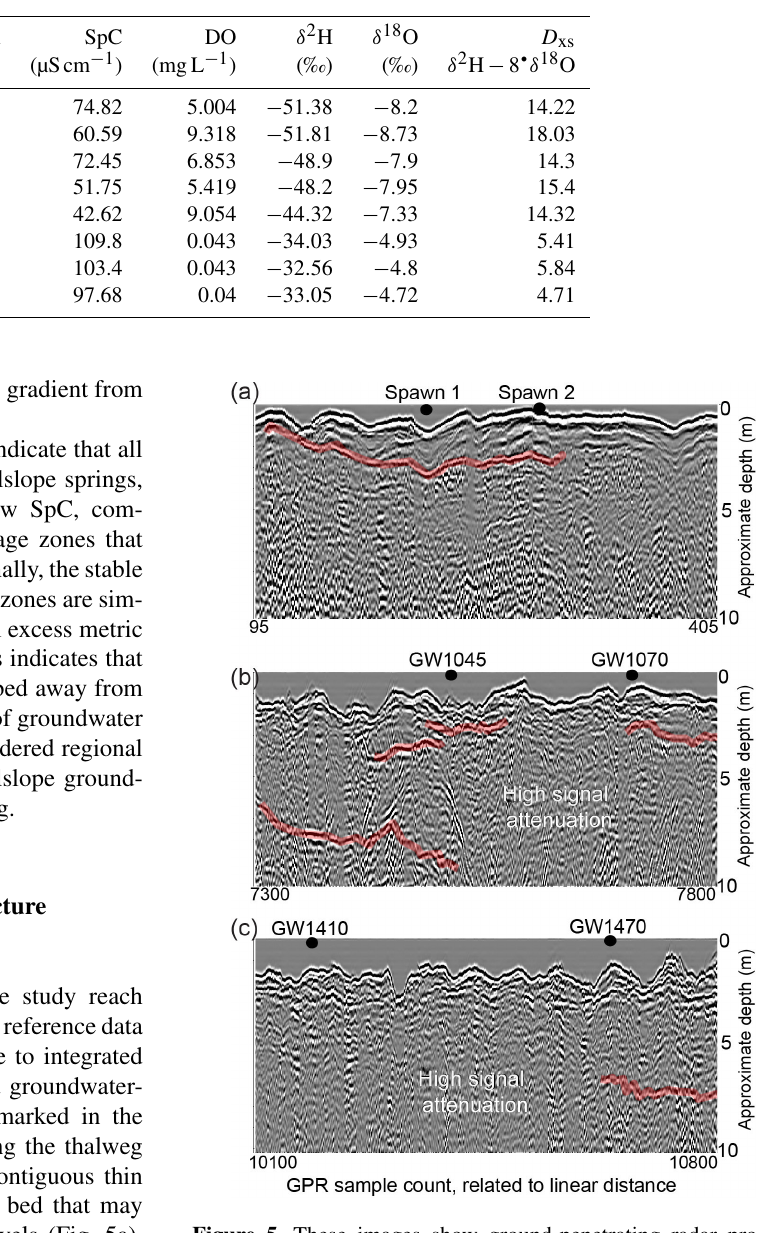
Figure 5. These images show ground-penetrating radar profiles collected down the center of the river channel to indicate peat, sand, and gravel layering in the stream bed. Stronger apparent radar reflectors are highlighted in red and likely indicate sedi- ment layer boundaries (e.g., sand and gravel vs. peat). Spawn- and groundwater-discharge locations were directly marked in the radar data stream during collection and are shown for each sub-reach